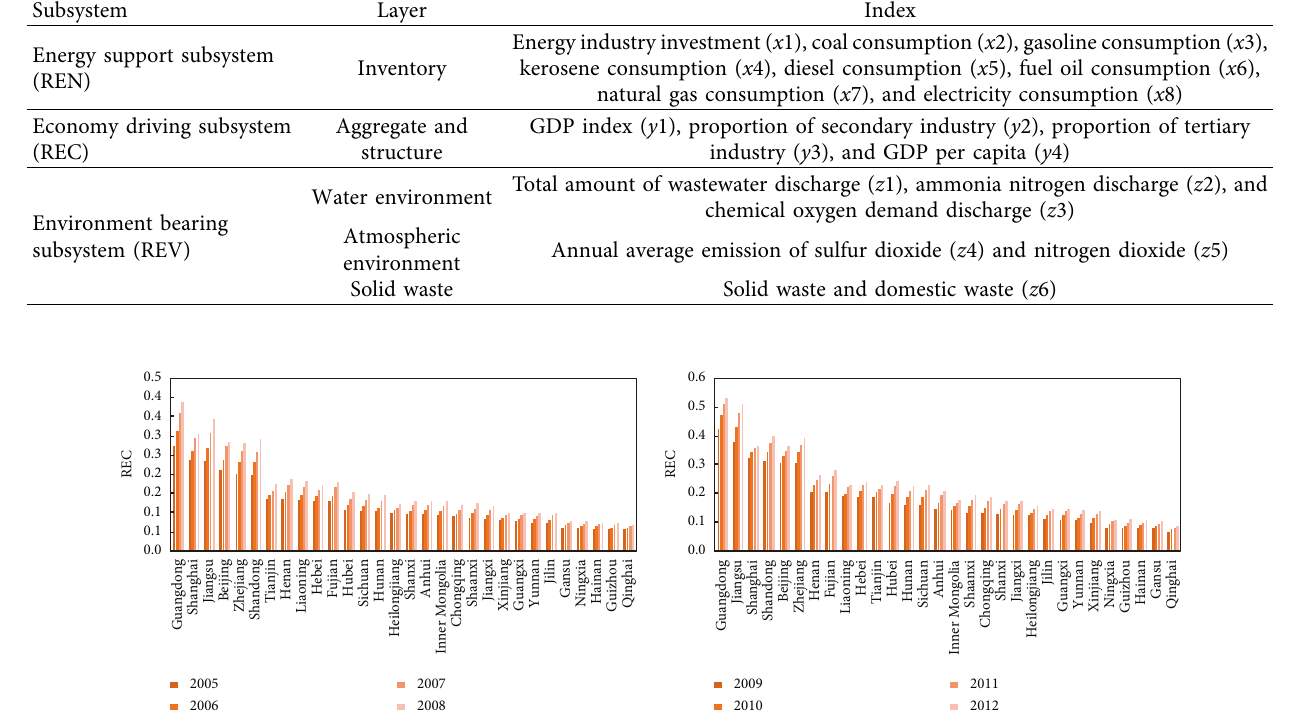
Table 1: Construction of the economy-energy-environment index